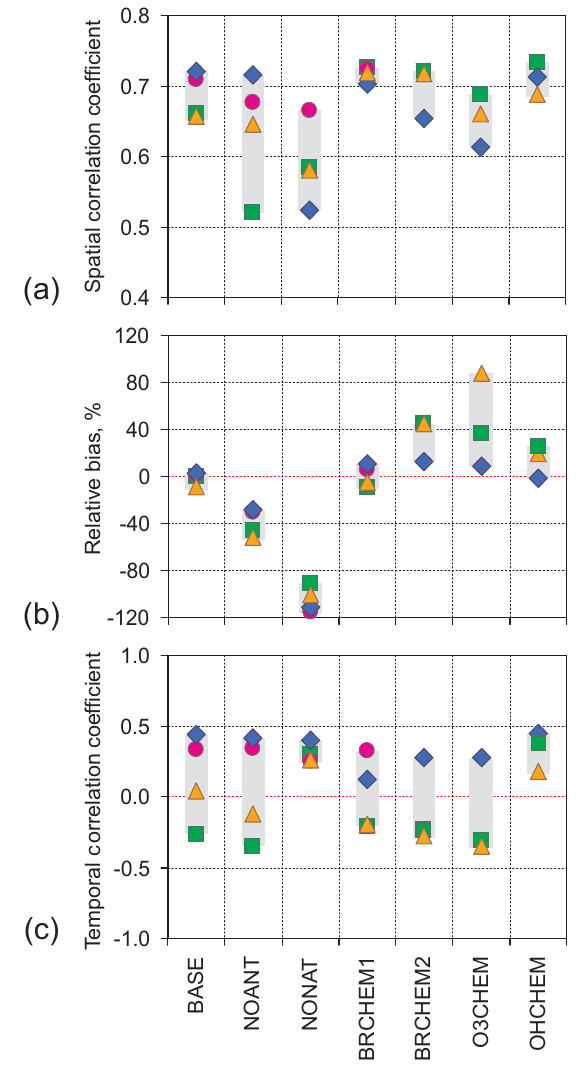
Figure 4. Spatial correlation coefficient (a) , relative bias (b) , and temporal correlation coefficient (c) of simulated and observed GEM air concentration for different model